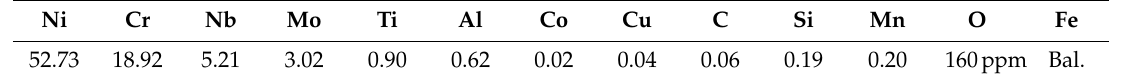
Table 2. Chemical composition of IN718 powder used in the V-SLM process (mass